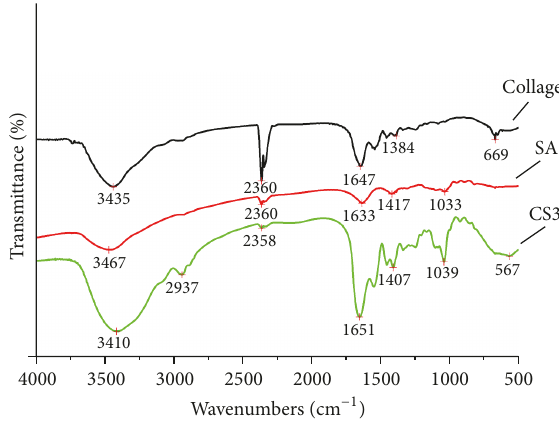
Figure 3: DSC thermograms of collagen, CS1, CS2, CS3, and SA films.